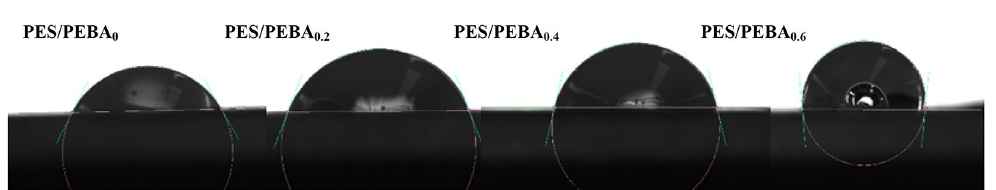
Figure 4. The XPS survey spectra of ( a ) PES/PEBA 0 and ( b ) PES/PEBA 0.6 separation membrane surfaces.